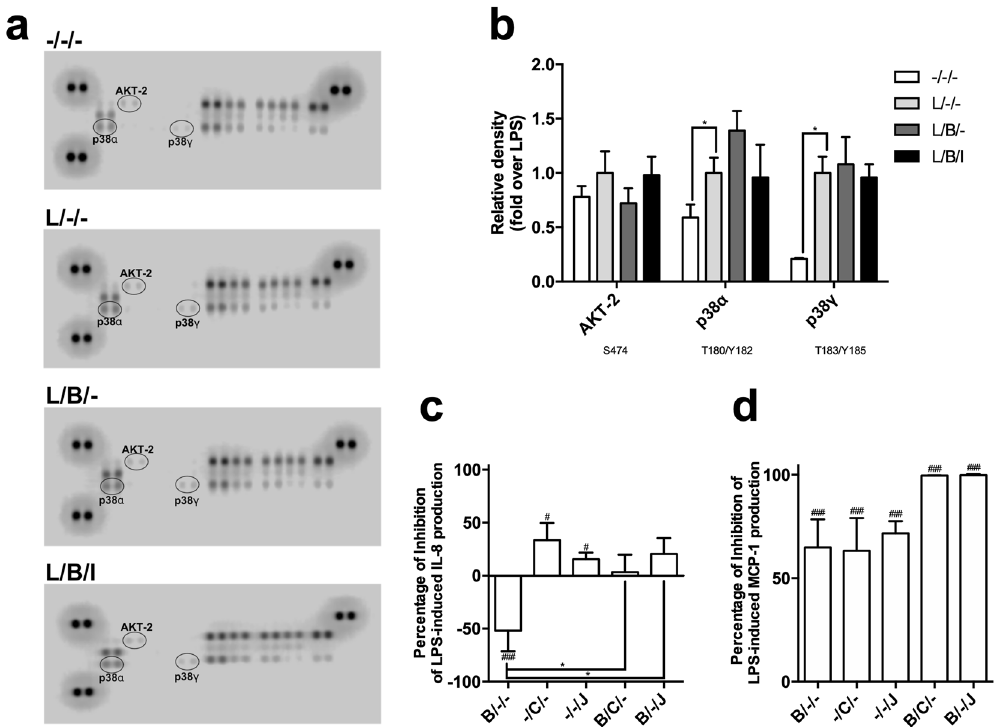
Figure 5. Impact of bindarit on LPS-induced activation of cellular kinases. MM-6 cells were left untreated ( − / − / − ) or treated with 100 ng/mL LPS (L) for 20 hours, in the absence (L/ − / − ) or presence of 300 μ M bindarit (B), used alone (L/B/ − ) or in combination with 5 μ M BMS309403 (L/B/I). Cell lysates containing 200 μ g of total protein were analyzed for the relative levels of site-specific phosphorylation of selected kinases, by using the human phospho-mitogen-activated protein kinase array kit. ( a ) Representative images of phospho-kinase arrays for each treatment captured by C-DiGit blot scanner. Each kinase is spotted in duplicate. The pairs of dots in each corner (with the exception of the negative control pair at the lower left corner) are positive controls. Each pair of the most positive kinase dots is denoted by an ellipse, with the name of the corresponding kinases. ( b) Graphical representation of the array signal intensities of AKT-2, p38 α and p38 γ . Below each kinase the specific phosphorylation site(s) detected is (are) reported. Relative spot phosphorylation was quantified by normalizing pixel density of the positive control to 100 and was expressed as a fraction ( ± S.D.) of the value of LPS-treated cells (n = 2). Significance is shown as P value calculated using a one-sample t -test. * P < 0.05. Effect of pharmacological inhibition of AKT-2 and p38 α on the immuno-modulatory activity of bindarit. Inhibition of the release of IL-8 ( c ) and MCP-1 ( d ) from LPS-stimulated monocytes by bindarit (B, 300 μ M), the AKT-2 inhibitor CCT128930 (C, 5 μ M) and the p38 α inhibitor JX-401 (J, 1 μ M), used alone (B/ − / − , − /C/ − and − / − /J) or in combination (B/C/ − and B/ − /J). After treatment, chemokine content was measured in the supernatants by AlphaLISA and